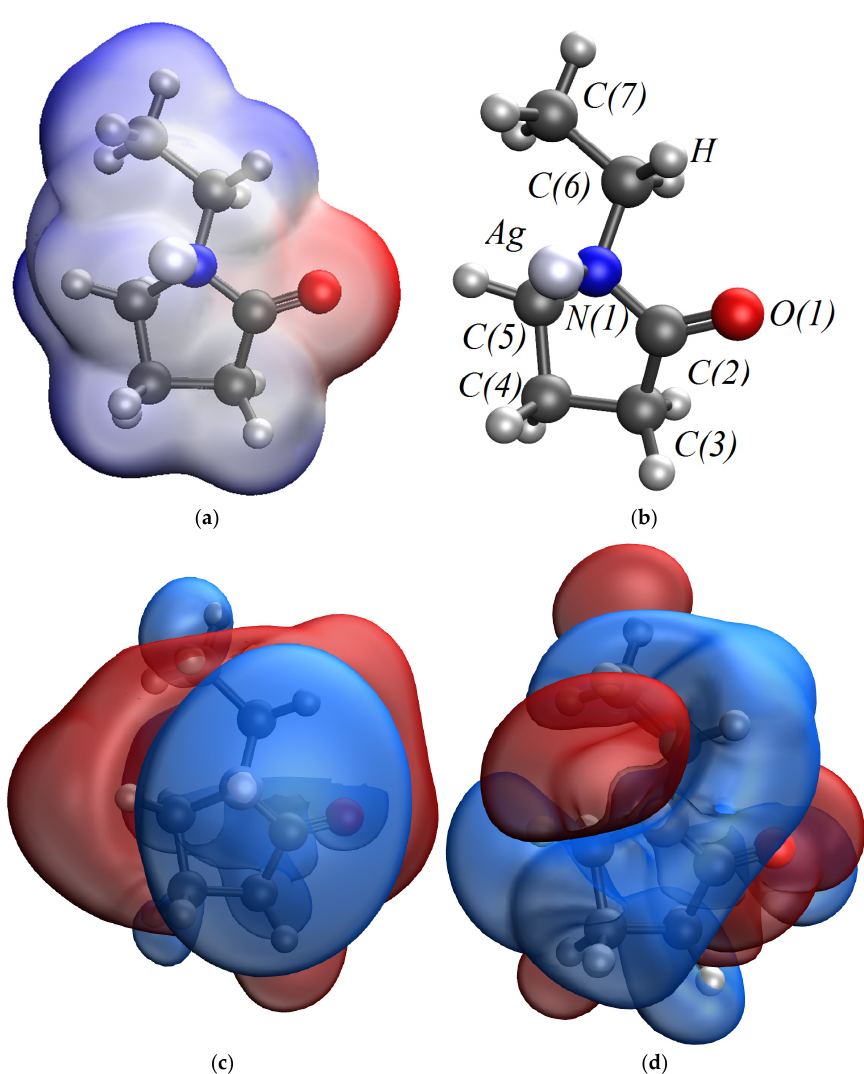
Figure 7. A model of the interaction of Ag atom with a PVP monomer unit through nitrogen: ( a )—the electron density distribution, ( b )—the Ag-PVP molecular complex model, ( c )—the model of the molecular orbital HOMO (highest occupied molecular orbital) and ( d )—the model of the molecular orbital LUMO (lowest unoccupied molecular orbital).